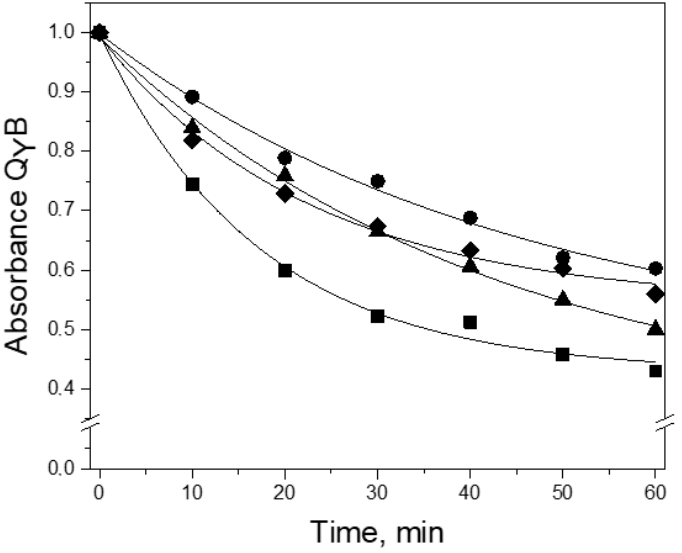
Figure 3. Changes in Q Y B absorption band amplitude in the spectra of the wild-type ( ▲ ), I(L177)H ( ■ ), F(M197)H ( ● ), and I(L177)H+F(M197)H ( ♦ ) RCs during their incubation in Tris-Triton buffer at 48 ᵒ C.